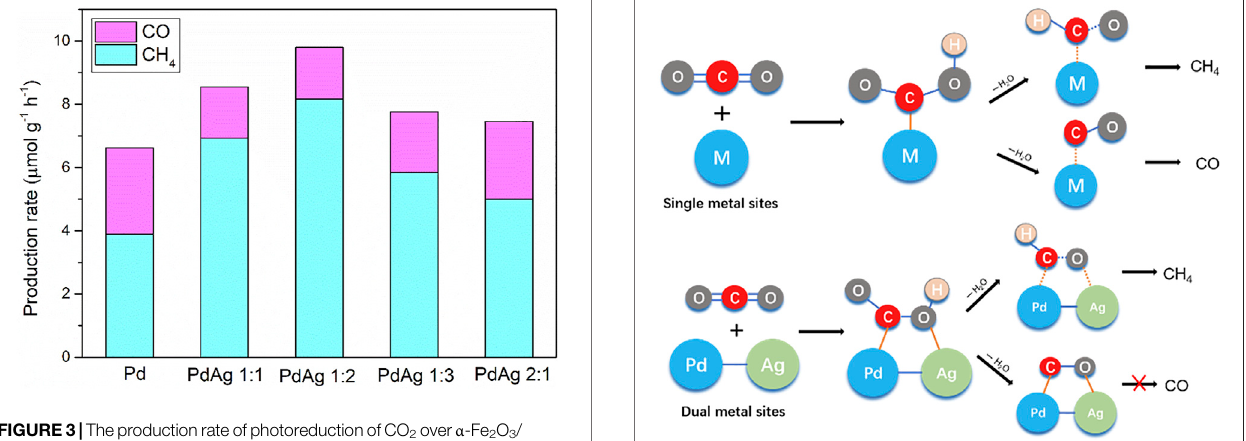
FIGURE3| TheproductionrateofphotoreductionofCO 2 over α -Fe 2 O 3 / CdS/PdAg of different Pd:Ag ratios.